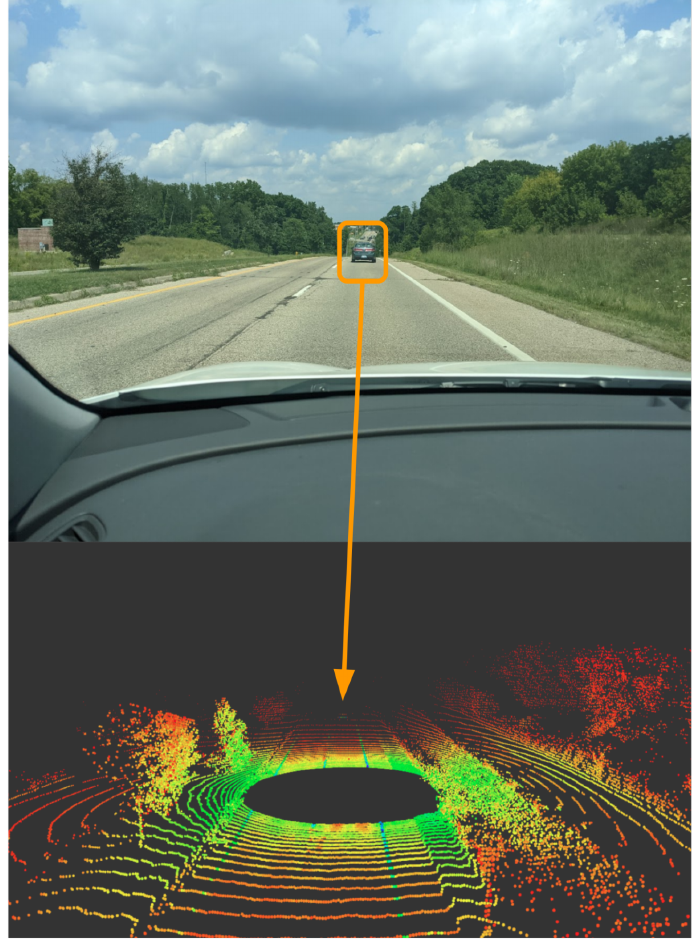
Figure 20. Ouster LiDAR visualization using Rviz with ROS.